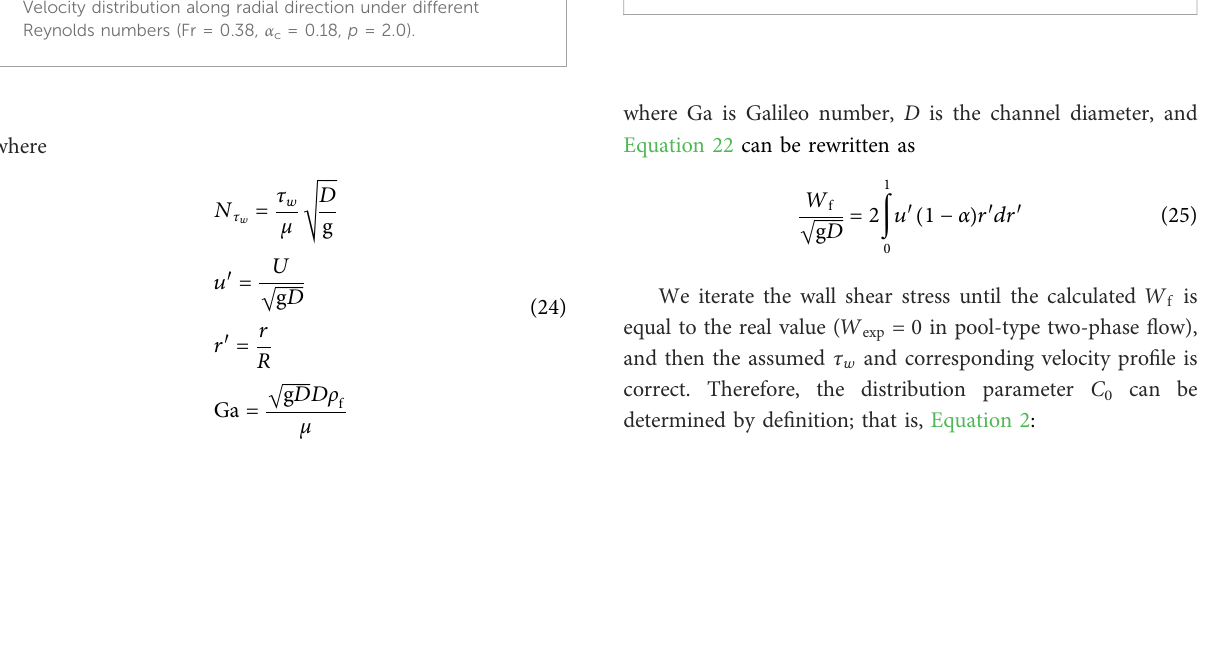
FIGURE 12 The effect of the void fraction on the distribution